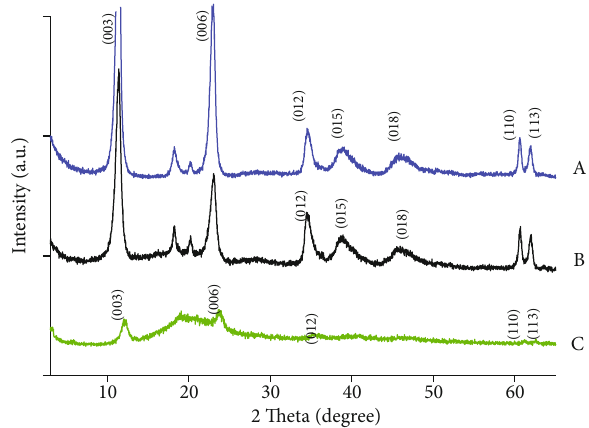
Figure 6: XRD patterns of LDH (a), GA-LDH (b), and GA-LDH/ LS